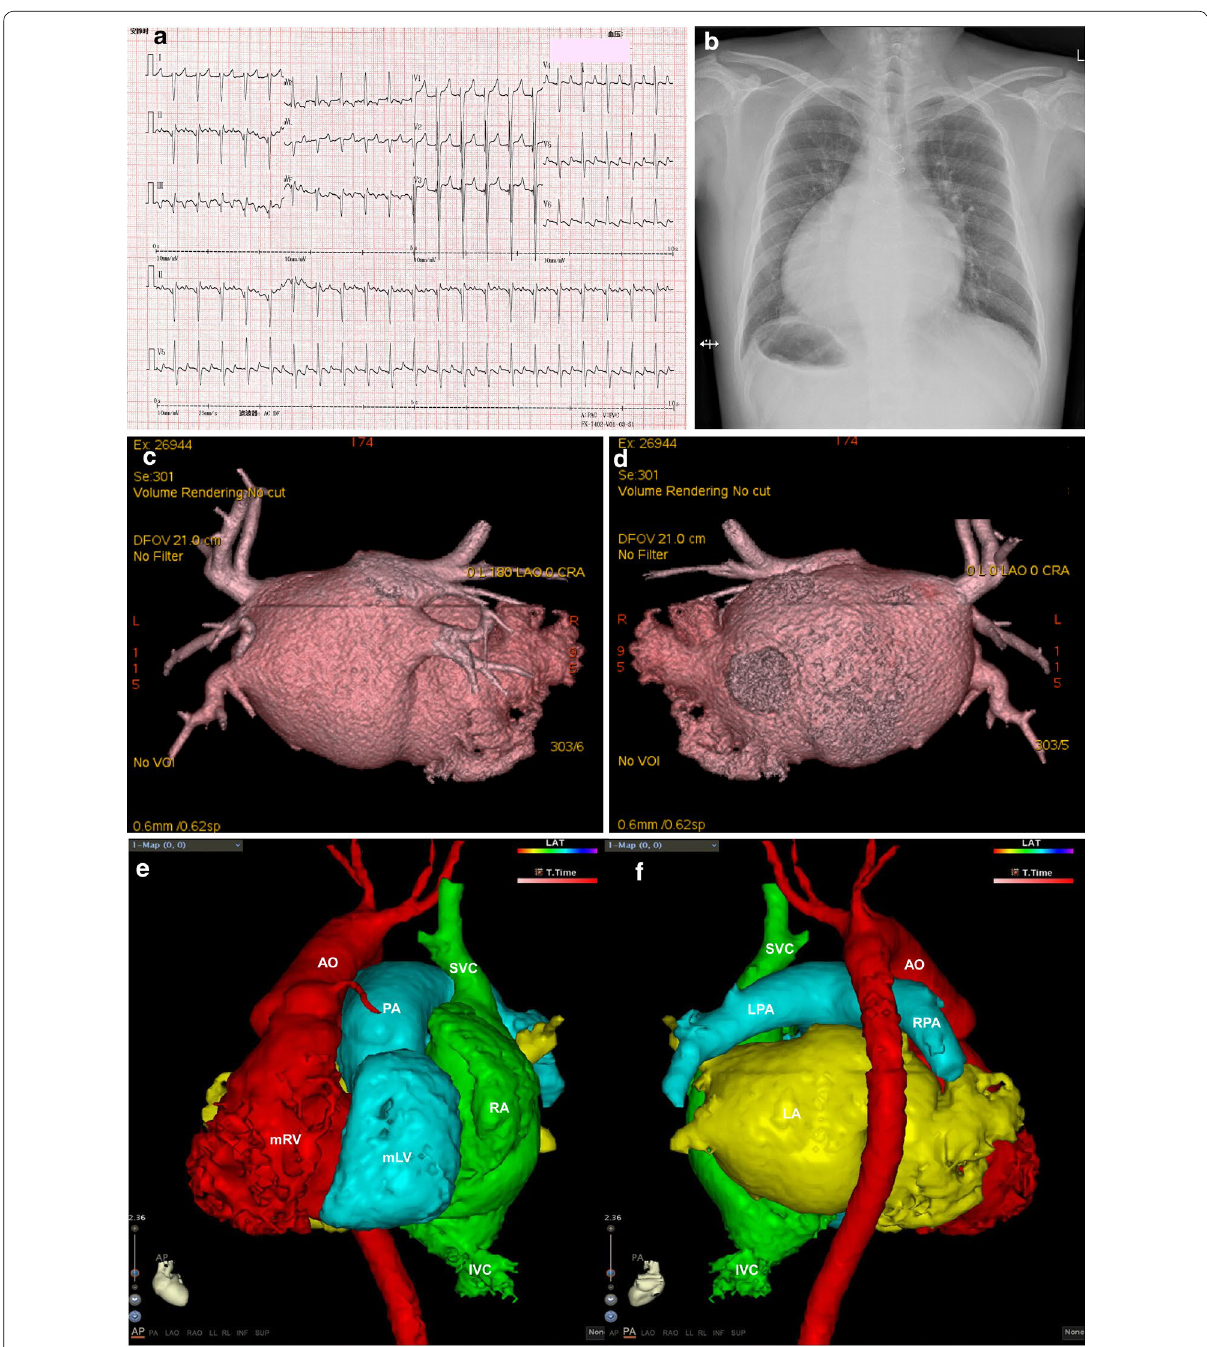
Fig. 1 Electrocardiograph and imaging data. a Electrocardiograph; b chest X-ray; c , d reconstructed geometric structure of LA by contrast-enhanced computed tomography; e , f reconstructed 3-dimensional imaging of atriums and ventricles. LA left atrium, RA right atrium, mRV morphological right ventricle, mLV morphological left ventricle, AO aorta, PA pulmonary artery, LPA left pulmonary artery, RPA right pulmonary artery, SVC superior vena cava, IVC Inferior vena